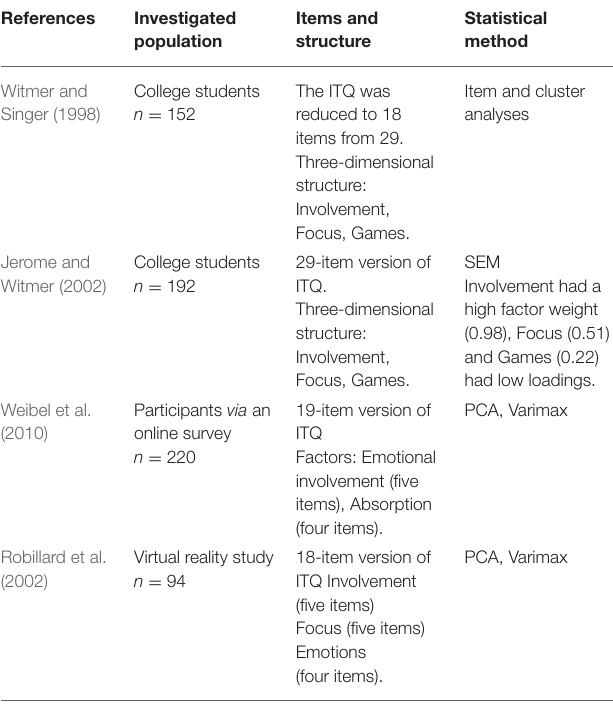
TABLE 1 | Overview of the results of the factor analyses of ITQ in international